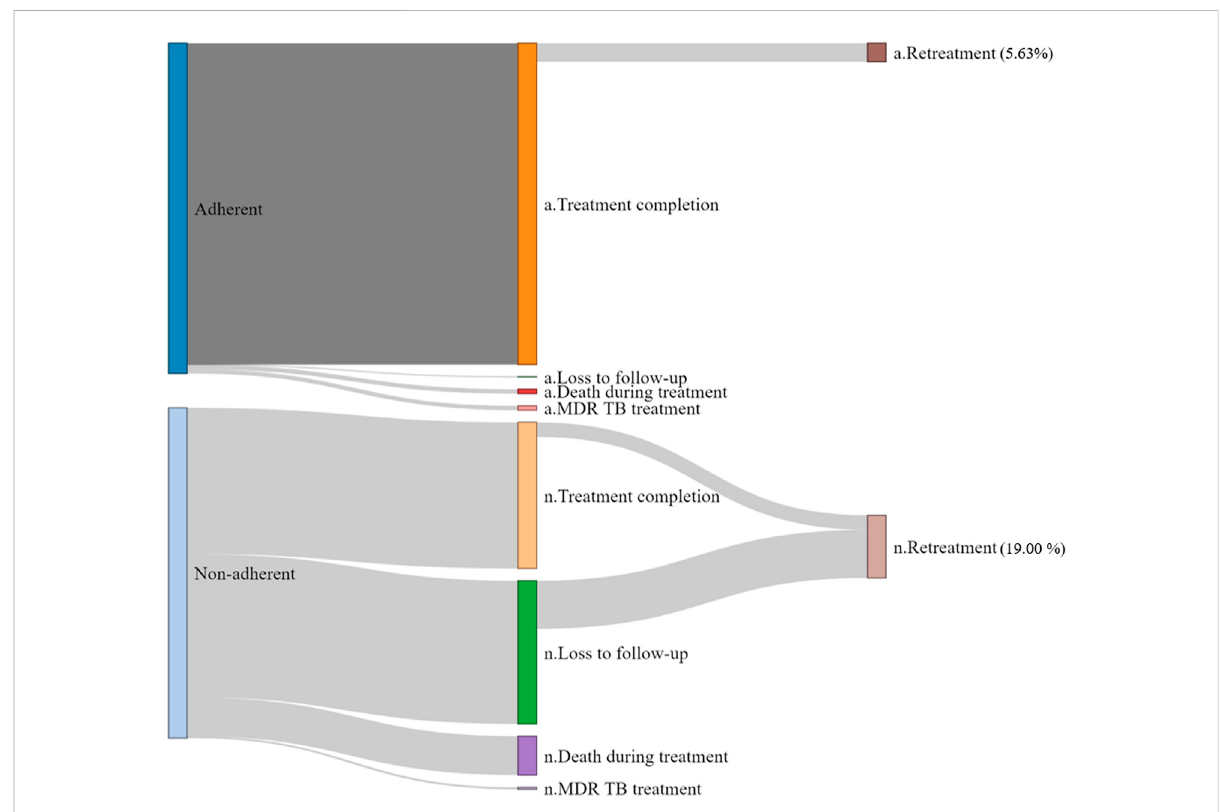
FIGURE 2 Tuberculosis-related cumulative cost per patient. Each line is a trend line for each